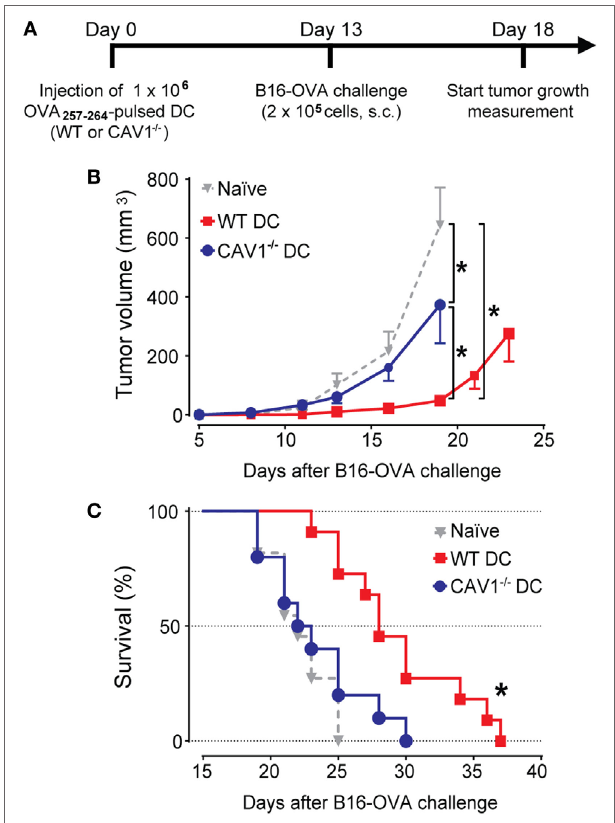
FigUre 5 | Caveolin-1 (CAV1) promotes dendritic cell (DC)-mediated antitumor protection. (a) Scheme showing experimental procedure. Initially, 1 × 10 6 OVA 257–265 -pulsed wild-type (WT) or CAV1 − / − BM-DCs were transferred to WT recipient mice. The control group was injected with PBS (vehicle). After 13 days, mice were challenged s.c. with 2 × 10 5 B16F10-OVA (B16-OVA) cells injected into the right flank. Tumor growth evaluation started 5 days after challenge and was carried out until all the animals were dead. The animals were sacrificed when the length, width, or height surpassed 15 mm. Groups were defined as: control mice group (gray triangles), OVA 257–265 -loaded WT (WT DCs, red squares), and OVA 257–265 -loaded CAV1 − / − DCs (CAV1 − / − DCs, blue circles). (B) Average tumor growth curves are shown (* p < 0.05, t -test, n = 8–10 mice). (c) Survival curves. The mean survival times were as follows: Ctrl group, 22 days; WT DC group, 28